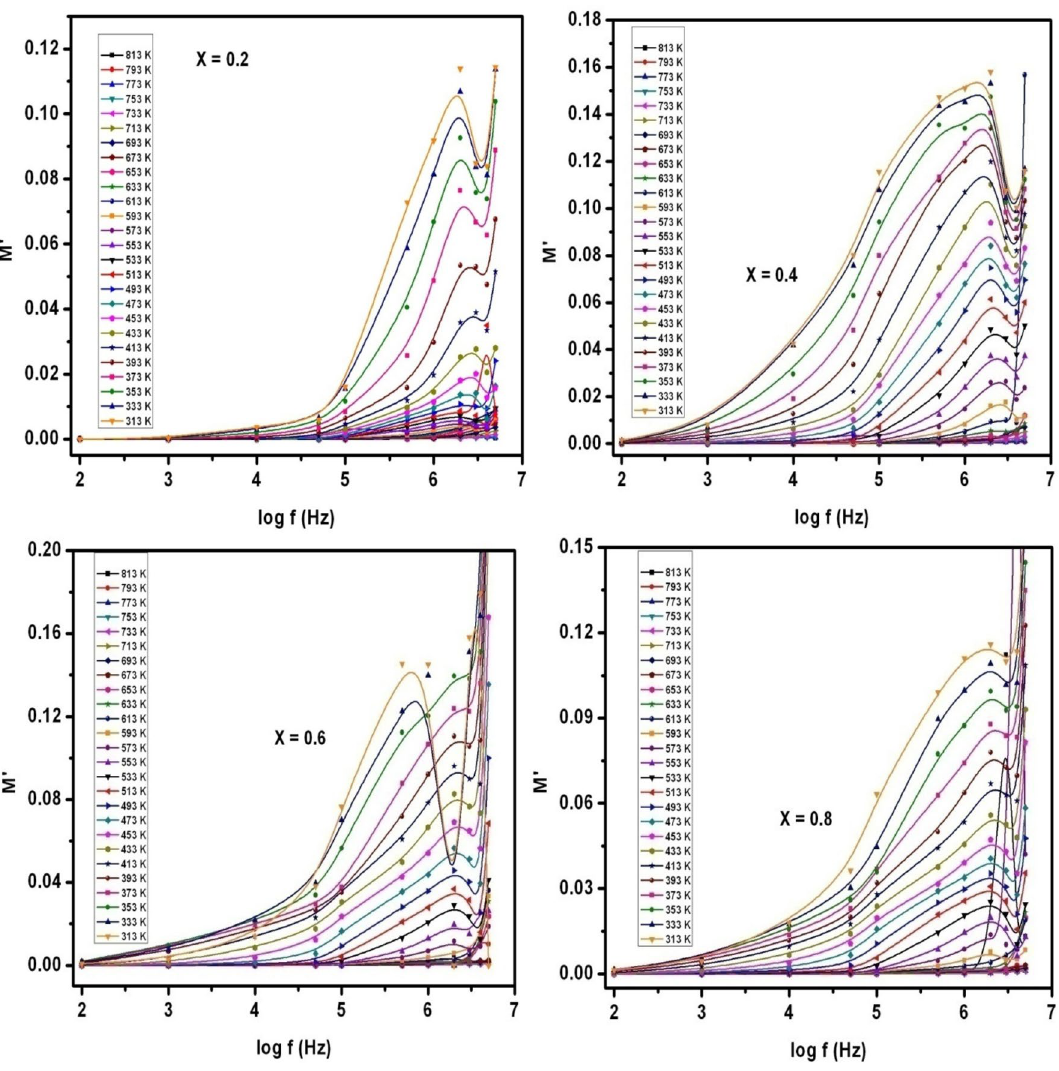
Figure 16. M ′ versus log f plots of SLFO